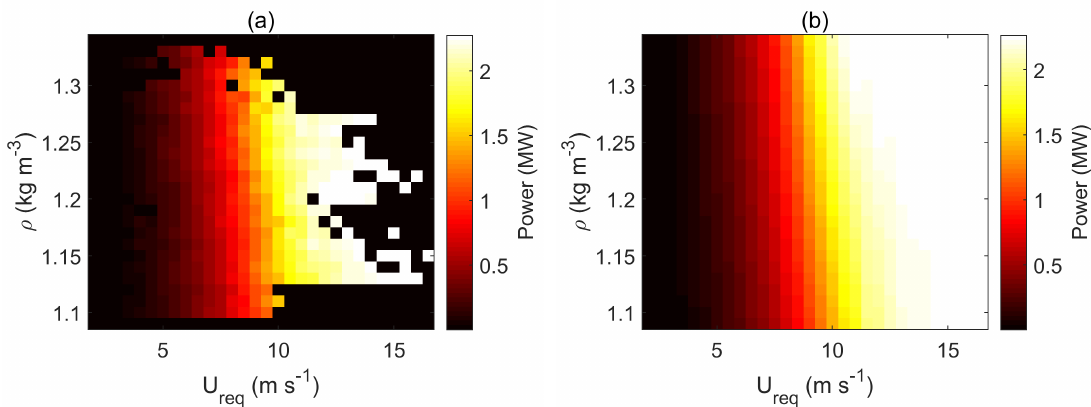
Figure 13. ( a ) Two dimensional binning of wind power in terms of rotor equivalent wind speed and density using available data; and ( b ) linear interpolation of available data for filling empty bins.